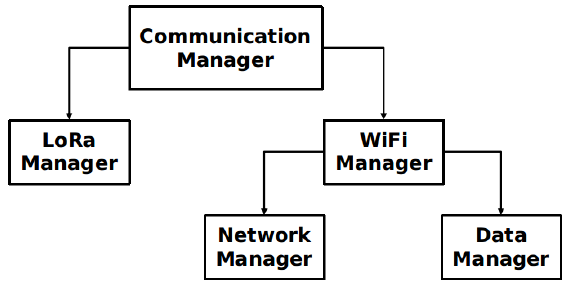
Figure 6. Multi-technology communication